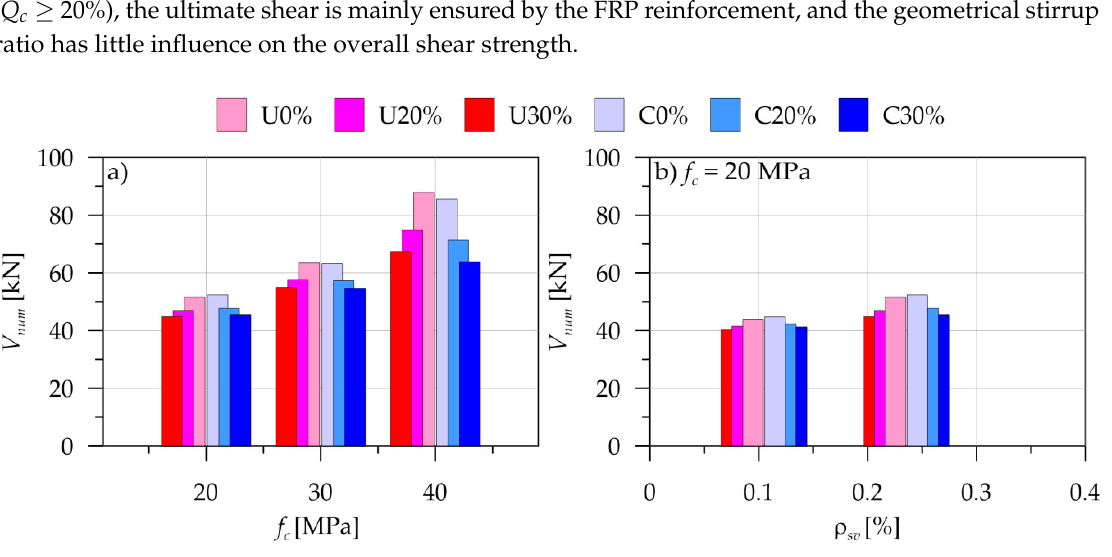
Figure 4. Effect of corrosion degree on the ultimate shear.